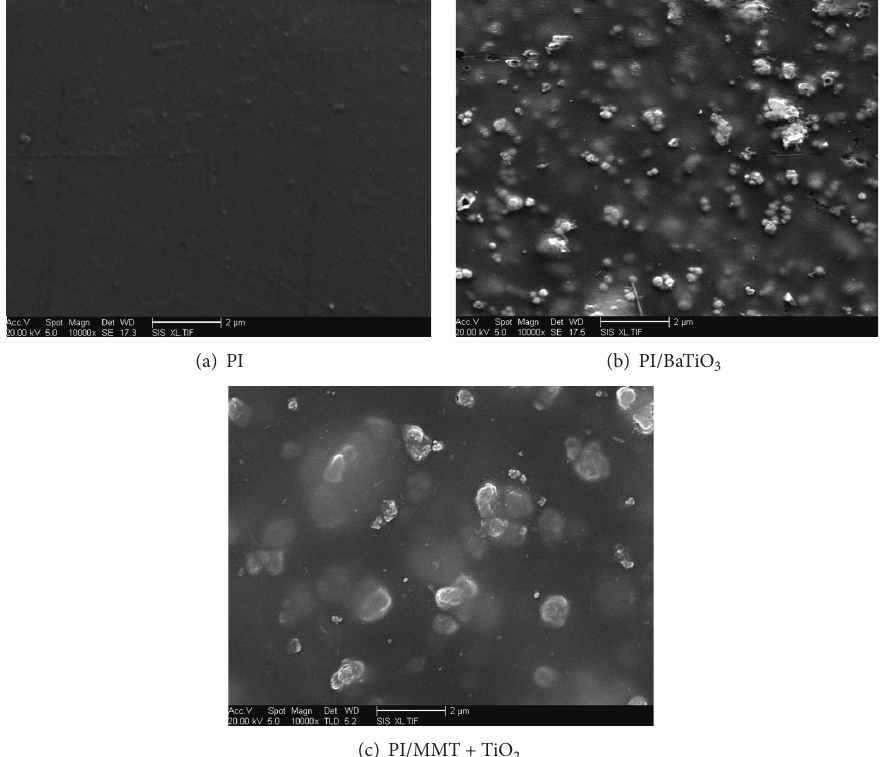
Figure 1: Surface morphology of three kinds of films through scanning electron